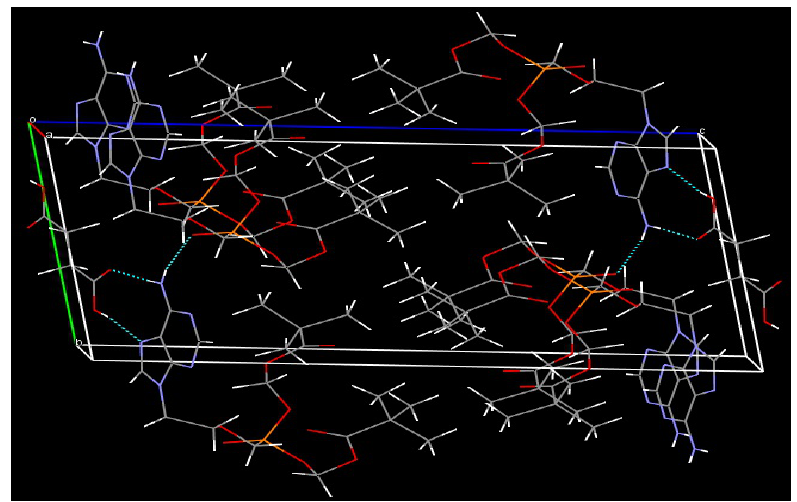
Figure 2. The previously reported structure of the stable form II of AD/SUC cocrystal: hydrogen bonds between molecules are indicated in turquoise dotted lines